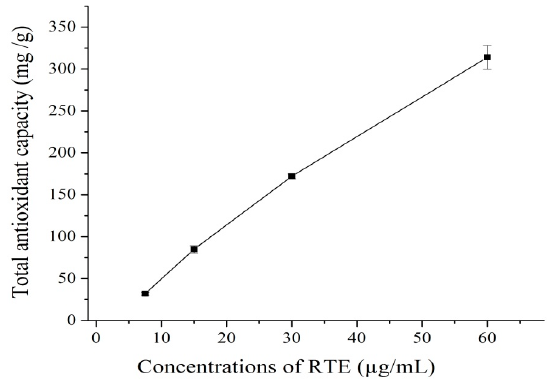
Figure 1. Total antioxidant capacity (mg of ascorbic acid equivalents/g dry weight) of the Rosa rugosa tea extract (RTE); means ± SD of triplicate analyses.